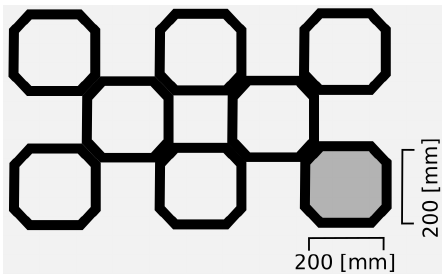
Figure 4. Schematic view of the checker bricks disposal inside the regenerator considered in the present